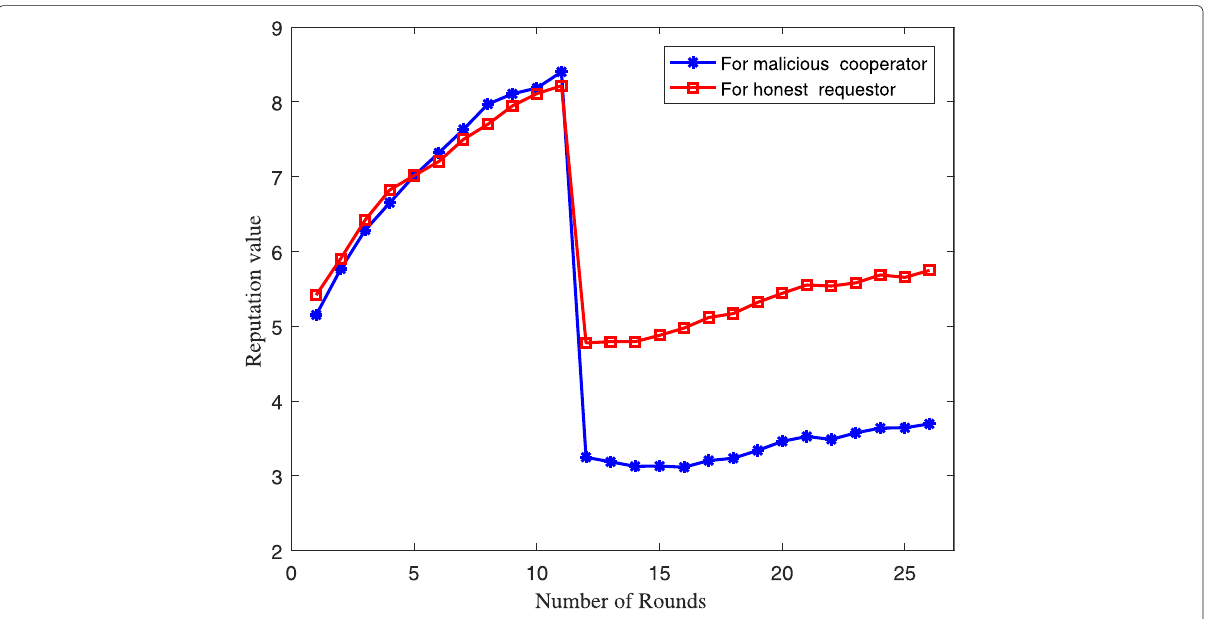
Fig. 8 The reputation of malicious cooperate nodes